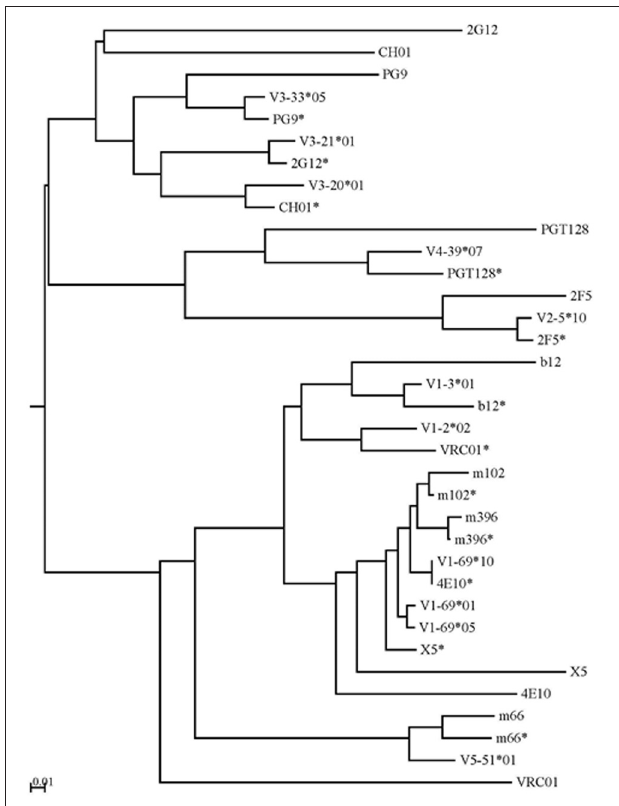
FIGURE 4 | The mid-point phylogeneticneighbor-joining tree shows the evolutionary relationships between different IGHVs of (bnAbs) with their corresponding germlines and intermediates. The IGHV germline gene alleles follow the IMGT nomenclature and the closest intermediates of bnAbs as found from the human IgM repertoire were designated with asterisks along with names of bnAbs. Some of the anti-HIV-1 antibodies (2G12, CH01, and VRC01) were found at distal nodes in the phylogenetic tree indicating high divergence from their corresponding germline and intermediate